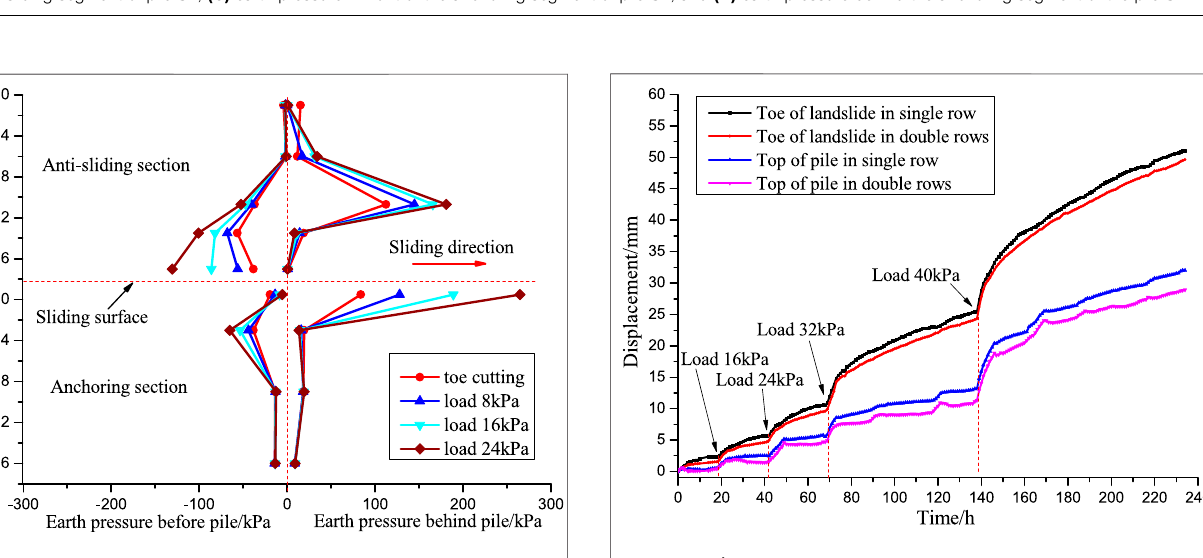
FIGURE 12 | Distribution of the earth pressure on pile S4. FIGURE 13 | Displacement variation at the monitoring